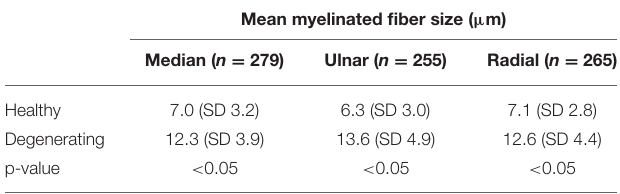
TABLE 4 | Mean myelinated fiber sizes in our study ( µ